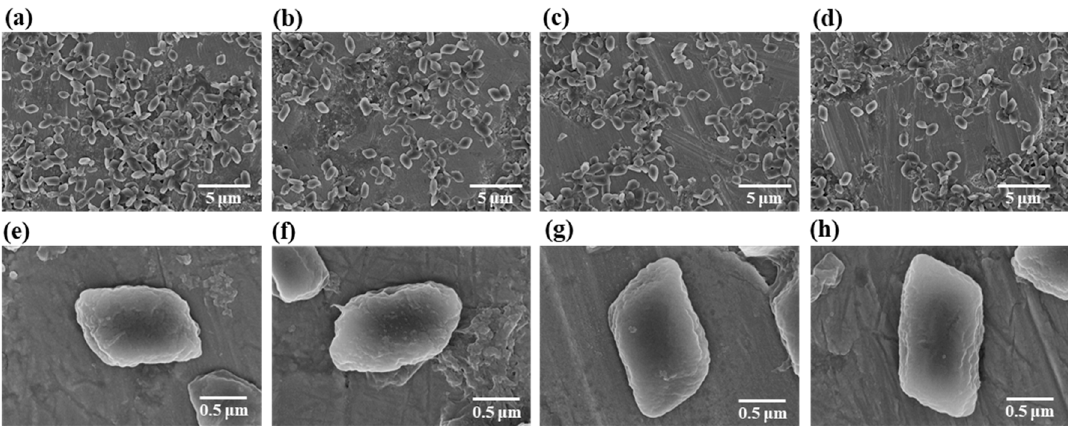
Figure 3. Size and morphological comparison of Cry3Aa and Cry3Aa-SmtA fusion crystals by scanning electron microscopy (SEM). Global SEM images of purified crystals of ( a ) Cry3Aa, ( b )